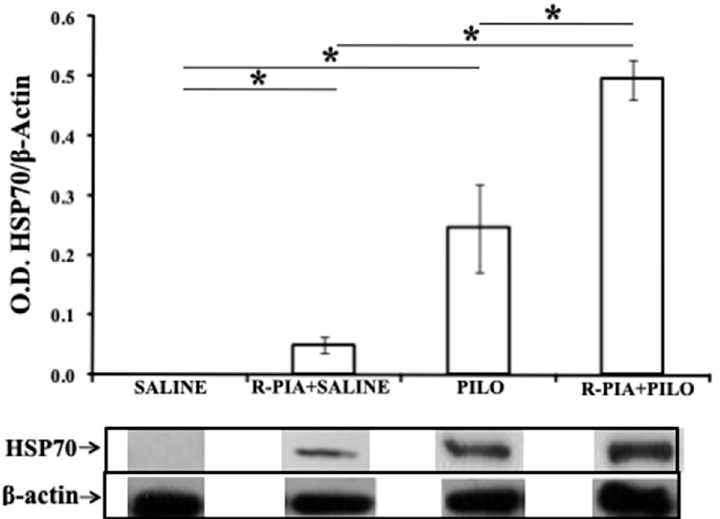
Figure 4. Expression of HSP70 in the hippocampal samples of rats from all studied groups. Bars represent the mean ± standard deviation of optical density for each group ( N = 4/group), normalized to β -actin levels. * p = 0.03 (Kruskal–Wallis with Wilcoxon post hoc).